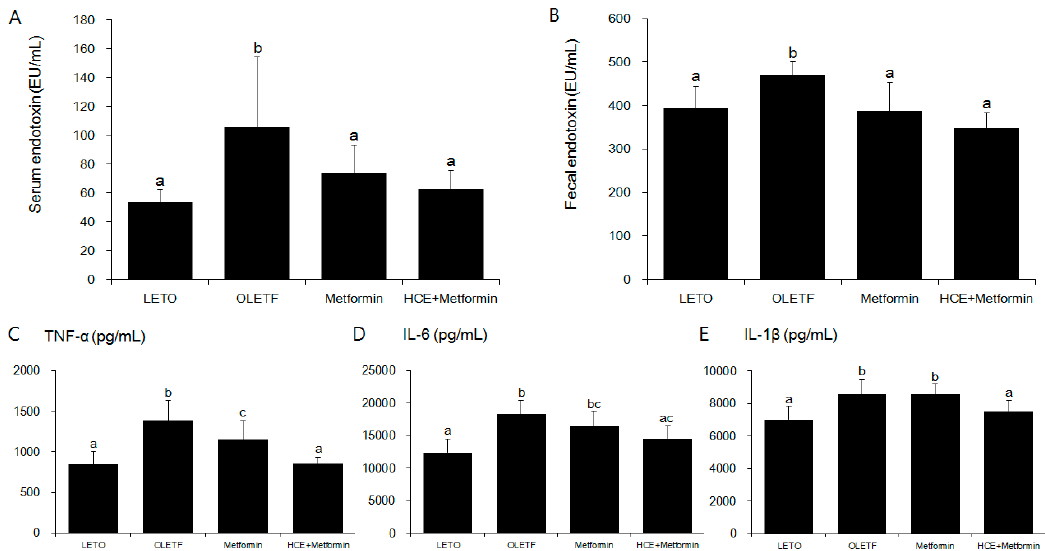
Figure 4. Effect of metformin either alone or in combination with HCE on the serum and fecal endotoxin levels ( A , B respectively); and the vital serum proinflammatory cytokines ( C – E ) in OLETF rats. Data with different letters are significantly different ( p < 0.05) according to one way ANOVA analysis. IL-6, interleukin 6; TNF- α , tumor necrosis factor alfa.